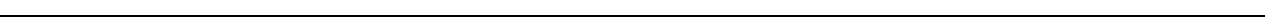
Fig. 2 CeLIN41 recognizes structured RNA. a Enrichment for each 11-mer structure motif in the CeLIN41 RNAcompete experiment was plotted against its overall occurrence in the RNA pool. Top 30 enriched 11-mer structures are highlighted in red and the corresponding dot-bracket strings are indicated. The dot-bracket strings correspond to a stem-loop motif, with exactly three nucleotides in the loop, schematically represented above. As controls, all structure 11-mers containing a loop with four, fi ve or six nucleotides, highlighted in cyan, blue and purple, did not show any enrichment. b CeLIN41 binding to parts of mab- 10 3 ′ -UTR. Top: schematics of the mab-10 3 ′ -UTR divided into six overlapping RNA probes (part 1 to 6), each of 200 nucleotides. Tri-loop SLs are present in parts 2 and 4. Single red asterisk on one side of the stem indicates a stem disrupting mutation (mut) and two red asterisks, one on each side of the stem, indicate a stem disrupting and the compensatory stem-restoring mutations (mut-res). Respective sequences are listed in Supplementary Table 1. Bottom: in gel-shift experiments, CeLIN41 bound to parts 2 and 4 of mab-10 3 ′ -UTR. Mutations disrupting the stems in part 2 and part 4 nearly abolished CeLIN41 binding. Compensatory mutations in the stems (mut-res) restored the binding to wild-type levels. c Top: the “ wt ” RNA corresponds to a synthetic “ Supplementary Table 1. Bottom: in gel-shift experiments, CeLIN41 bound the synthetic mab-10 condensed 3 ′ -UTR. Mutations disrupting the stem (mut) abolished binding, whereas compensatory mutations (mut-res) restored binding. d Micrographs of early L3-stage C. elegans larvae, treated with either lin-41 or mock RNAi, showing reporter GFP in hypodermal nuclei (white circles demarcate nuclei), expressed from the lin-29A promoter under the control of unregulated act-1 5 ′ -UTR and unc-54 (ctrl) 3 ′ -UTR. The 3 ′ -UTR insert corresponds to the constructs in c . The mab-10 condensed 3 ′ -UTR imposed CeLIN41- mediated repression on the GFP reporter. Mutations disrupting the stem abolished this regulation (white arrowheads point to GFP-expressing nuclei), while compensatory mutations reinstated the repression. Scale bars, 10 µ